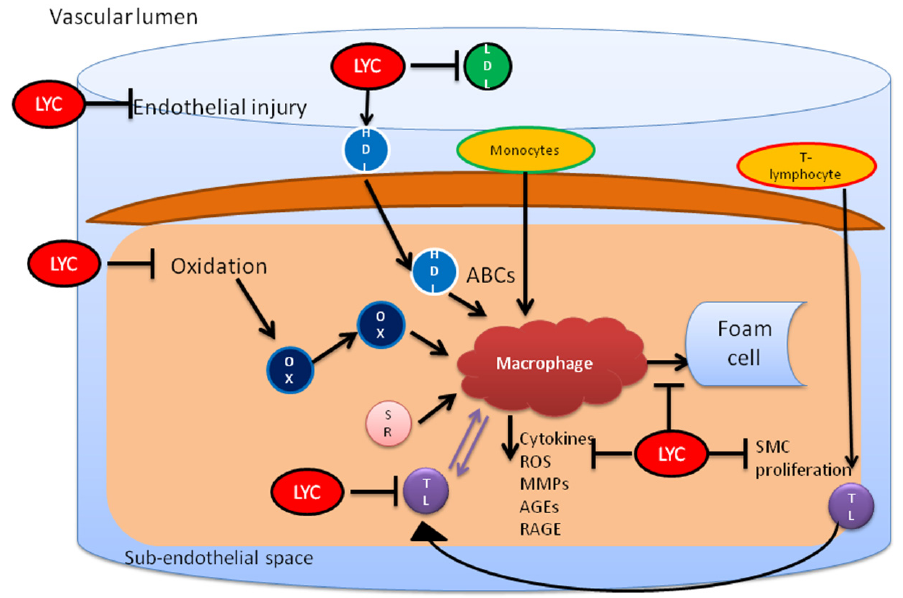
Figure 3. Lycopene inhibits endothelial injury and cholesterol by preventing oxidation of LDL. It also restores the functionality of HDL and prevents the proinflammatory activity initiated by T lymphocytes and macrophages. This leads to inhibition of foam cell formation from macrophages. LYC, lycopene; OX, oxidized HDL; MO, monocytes; ABCs, ATP-binding cassette transporters; MMP, metalloproteinases; AGE, advanced glycation end products; SMC, smooth muscle cells.